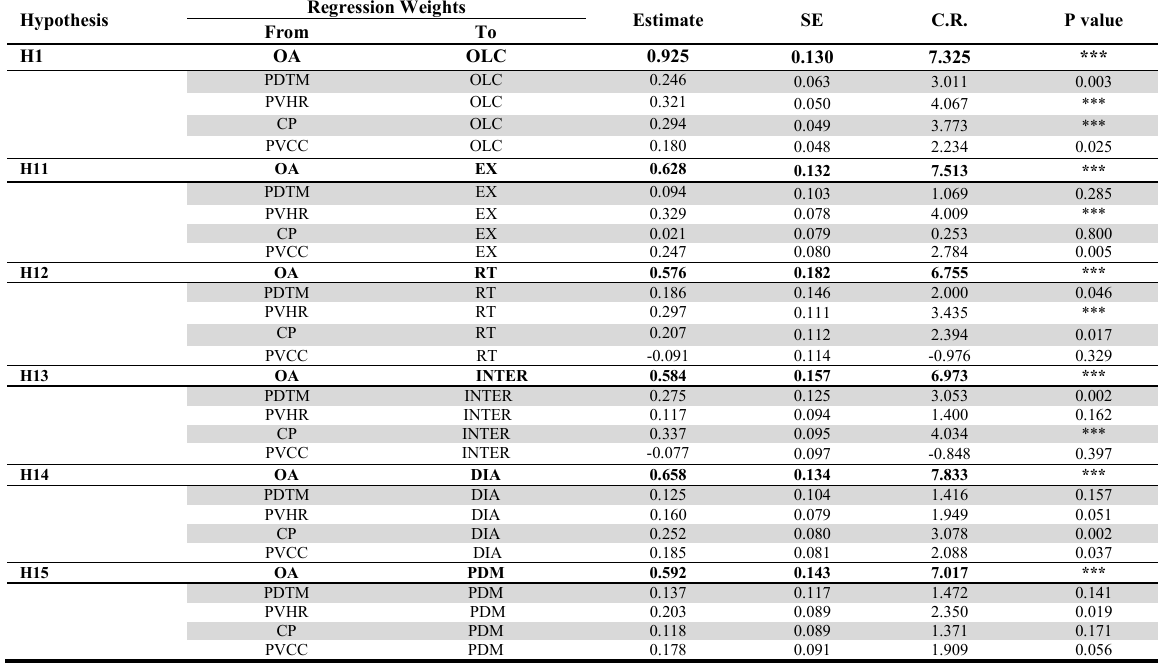
Results of Hypotheses Testing